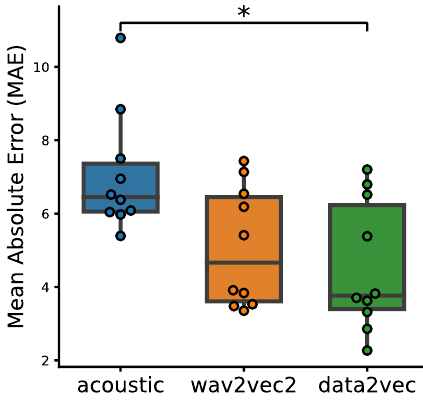
Figure 6. Boxplots of the mean absolute error results for embeddings from data2vec and wav2vec2 and acoustic feature set using the AD severity predictor based on the 10-fold cross-validation. A Kruskal – Wallis H -test showed that there is a statistically significant difference between the groups ( H = 6.9083, p = 0.0316). A post hoc Dunn’s test further showed that data vec is statistically signifi- cantly different at p = 0.0103